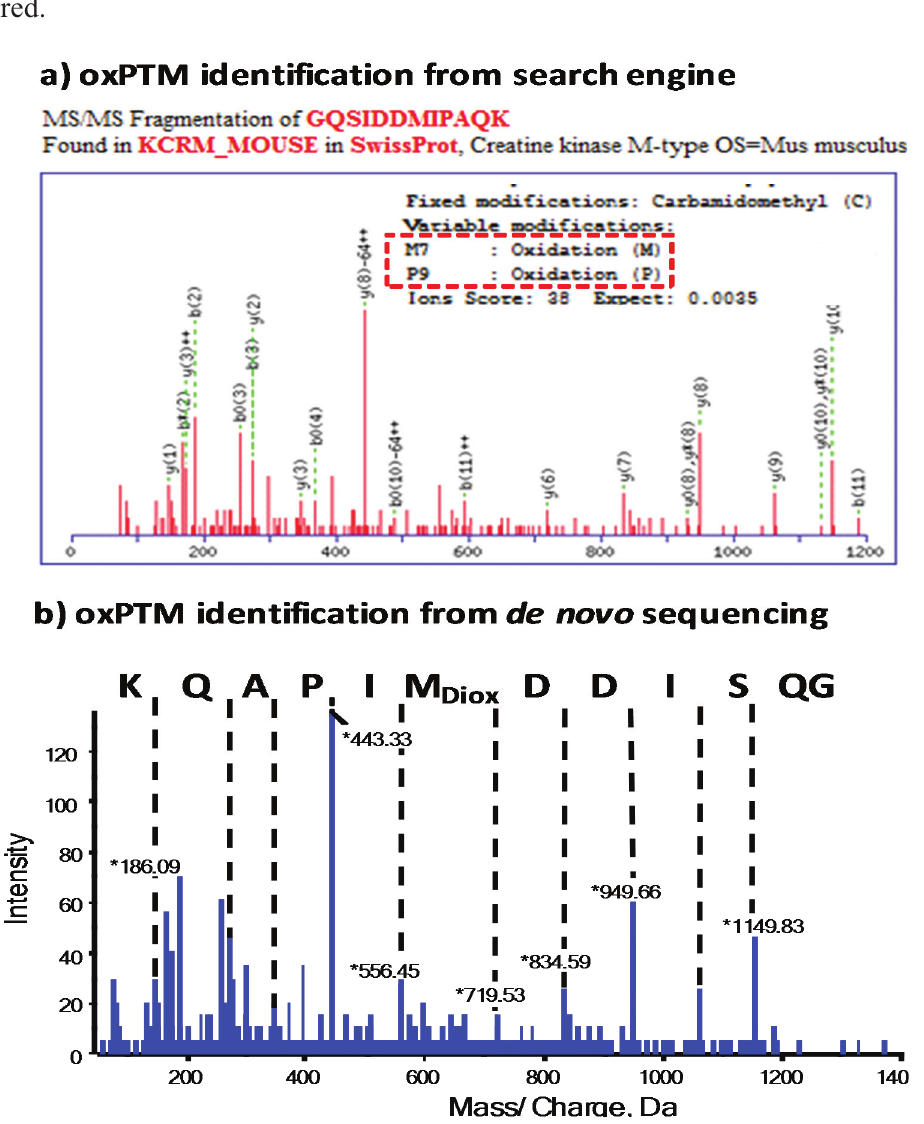
Figure 3. Incorrectly assigned oxidation to proline using a probability-based search engine. ( a ) Search engine identified 2 modifications on one peptide: methionine-7 mono-oxidation and proline-9 oxidation; ( b ) de novo sequencing showed that methionine is